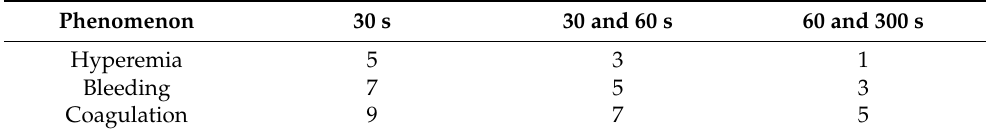
Table 6. Numerical graduation (1, 3, 5, 7, and 9) of the phenomena as a function of the elapsed time (seconds) for their